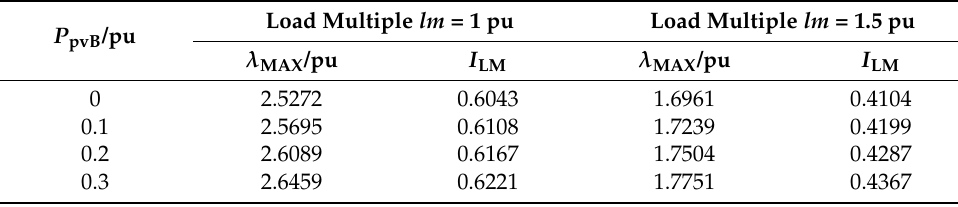
Table 5. Values of system load-margin index (Plan B, active output of Gen 2 P G2 = 0.4 pu). P pvB